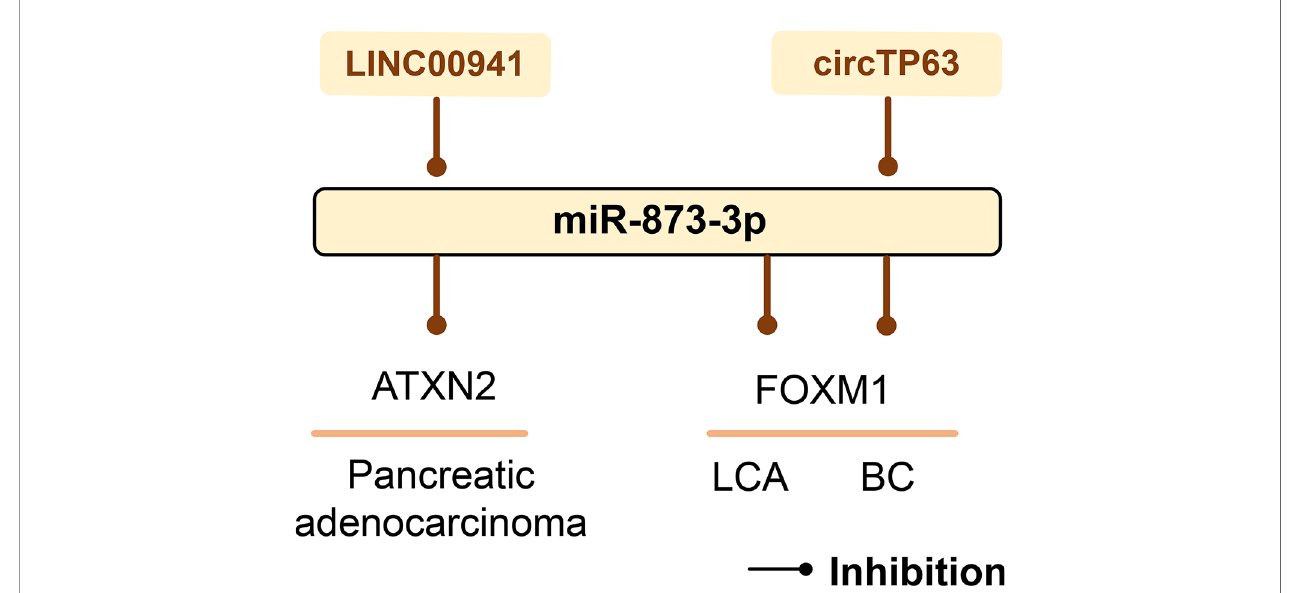
FIGURE 8 | The role of miR-873-3p in human cancer. mir-873-3p plays an important role in pancreatic adenocarcinoma, LCA, and BC by regulating target genes. LINC00941 and circTP63 can sponge miR-873-3p and thus affect cancer development. LCA, lung cancer; BC, breast cancer.